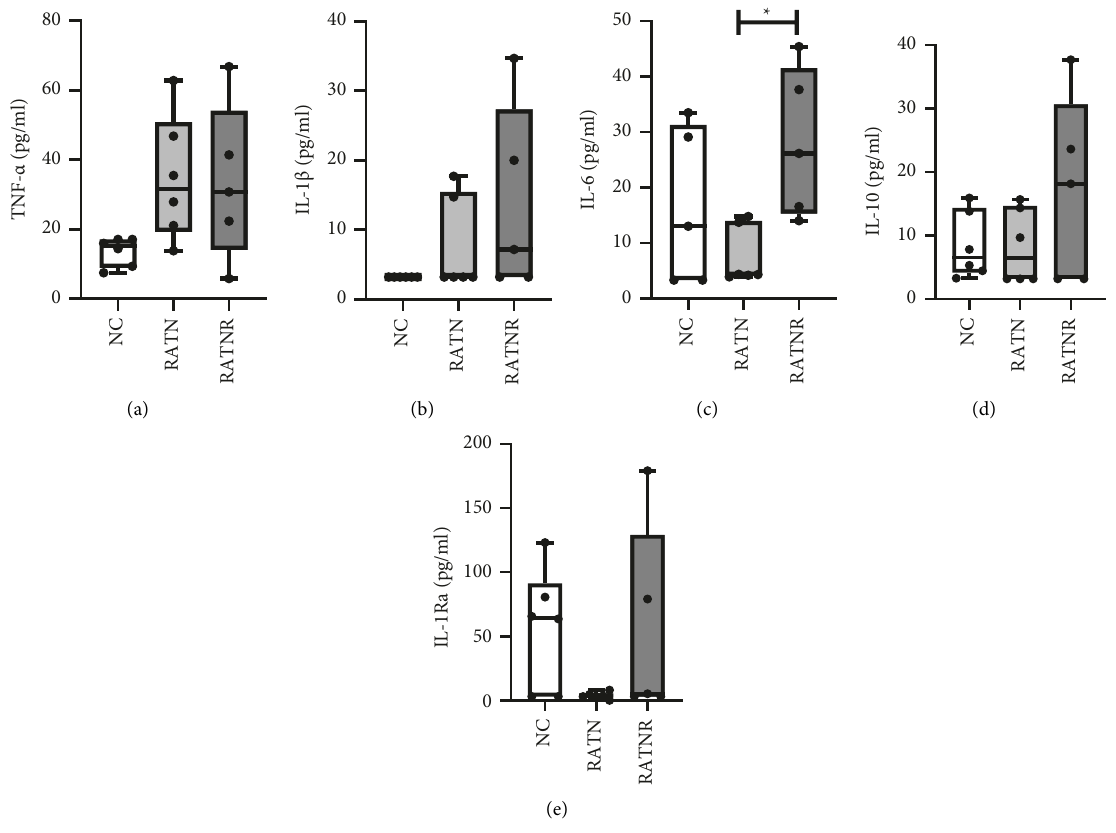
Figure 2: Patient plasma cytokine concentration in healthy (NC), RA treatment na¨ıve (RATN), and RA treatment-nonresponding (RATNR) patients. (a) TNF- α ; (b) IL-1 β ; (c) IL-6; (d) IL-10; and (e) IL-1Ra. Statistical analysis: one-way ANOVA. ∗ � p < 0 . 05. n � 6 per group. Data represented as box and whisker plots indicating the highest and lowest values, and the median and the interquartile range, as well as individual data points. TNF- α � tumour necrosis factor- α ; IL � interleukin.